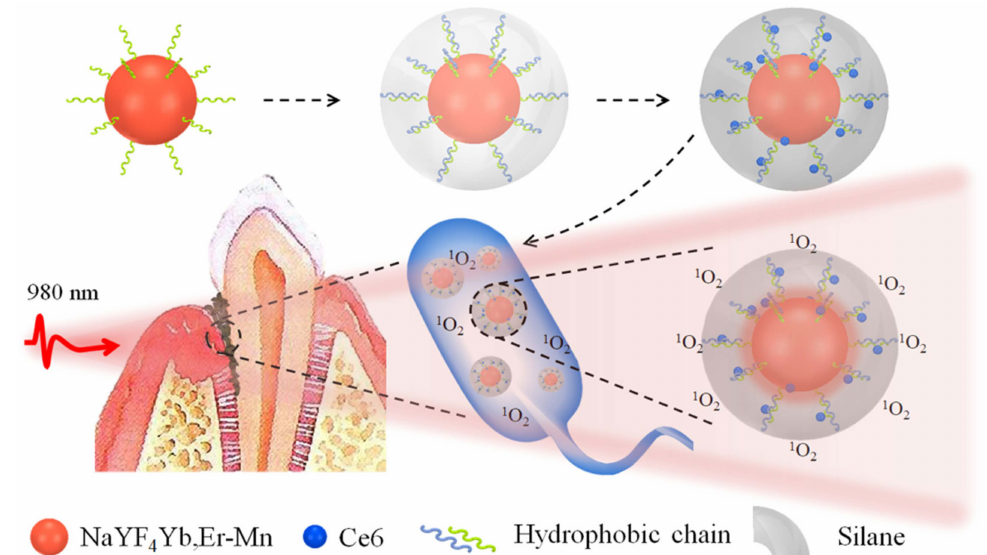
Figure 1. The schematic diagram of the composite structure.Ce6 and NaYF 4 :Yb,Er UCNPs were combined with amphiphilic silane modification through hydrophobic-hydrophobic interaction. Hydrophobicsidechainofthesilane(blue)andhydrophobicgroup(green)onthesurfaceofNaYF 4 :Yb,Er UCNPs can attach each other forming the close coating layer. After entering into the bacteria in the area of periodontal disease, singlet oxygen ( 1 O 2 ) can be e ff ectively produced under the irradiation of 980 nm irradiation as shown in the figure. Mn doping greatly enhances the red emission and then the aPDT